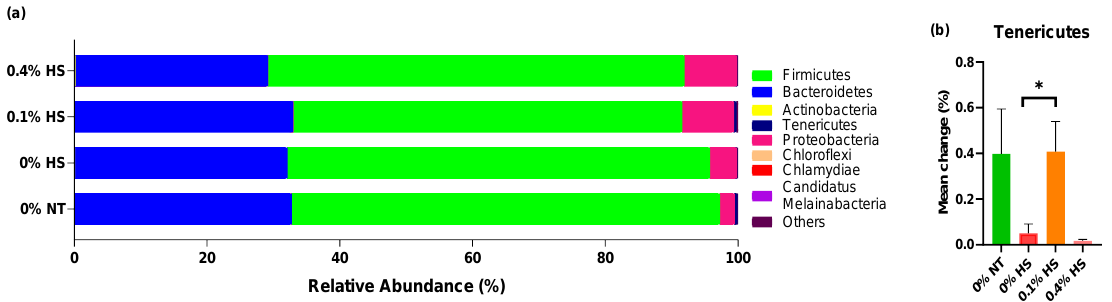
Figure 4. Effects of supplementing diets with solubles from shredded, steam-exploded pine particles (SSPPs) on the cecum microbial profiles of bacterial phyla ( a ) and significantly modified bacterial phyla ( b ) in broiler chickens exposed to either thermoneutral or heat-stress conditions. Chickens were fed with diets containing 0% (control), 0.1%, and 0.4% SSPP from the 8th day to the 36th day of age. On the 37th day, birds were either kept at thermoneutral temperature (21.0 ◦ C) and provided a control diet (0% NT) or heat-stressed at 31.0 ◦ C for six hours and provided a diet supplemented with 0% (0% HS), 0.1% (0.1% HS), or 0.4% (0.4% HS) SSPPs. Data show means ± SEM (n = 6). Abbreviations: NT, normal temperature; HS, heat stress. *, significant difference at p < 0.1. Firmicutes and Bacteroidetes were inversely correlated (Spearman R = −0.837, p = 0.001) with each other. Similarly, Tenericutes (Spearman R = −0.418, p = 0.042) was also inversely correlated with Actinobacteria (Figure 5).